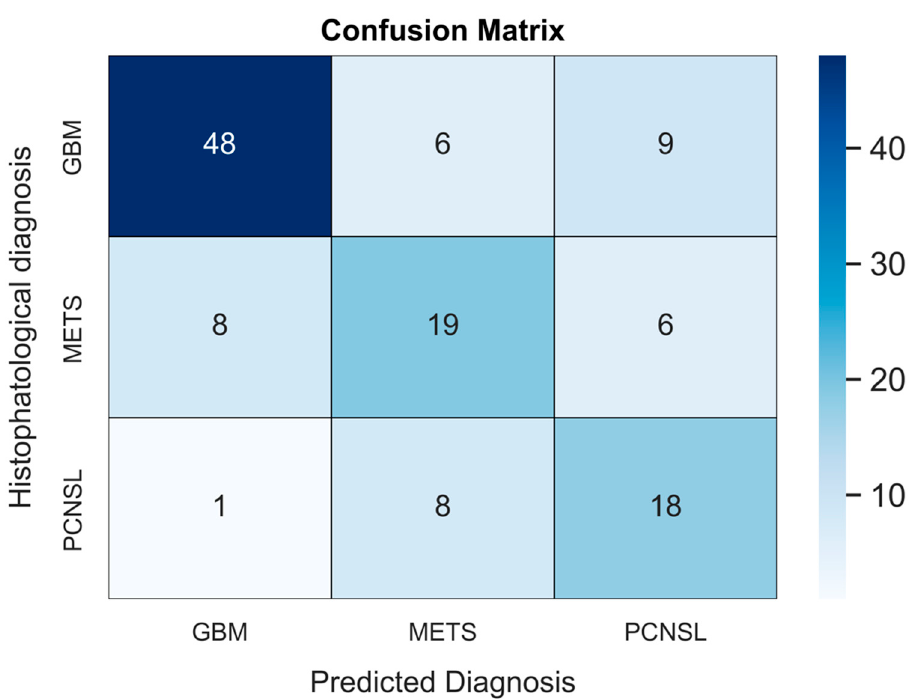
Figure 5. The confusion matrix (CM) shows the exact collocation of each patient among classification classes during a validated simulation with our DNN model. On the TeS patients’ data, the model misclassified histologically-confirmed atypical PCNSL nine times: in eight out of nine cases, the error led to a computer-based diagnosis of BM. On the contrary, among histologically-diagnosed BM, the model correctly identified 19 cases, while the remaining 14 cases were declared as glioblastomas ( n = 8) and PCNSLs ( n = 6). Overall, glioblastomas were more likely to be correctly diagnosed by the DNN model. The CM shows how the model chose among available diagnostic classes in the current work. BM: brain metastasis; CM: Confusion matrix; DNN: deep neural network; GBM: glioblastoma; PCNSL: primary central nervous system lymphoma. Table 3. Neuroradiologist (Gold standard) performance metrics in differentiating PCNSL, glioblas- toma and BM in the cohort